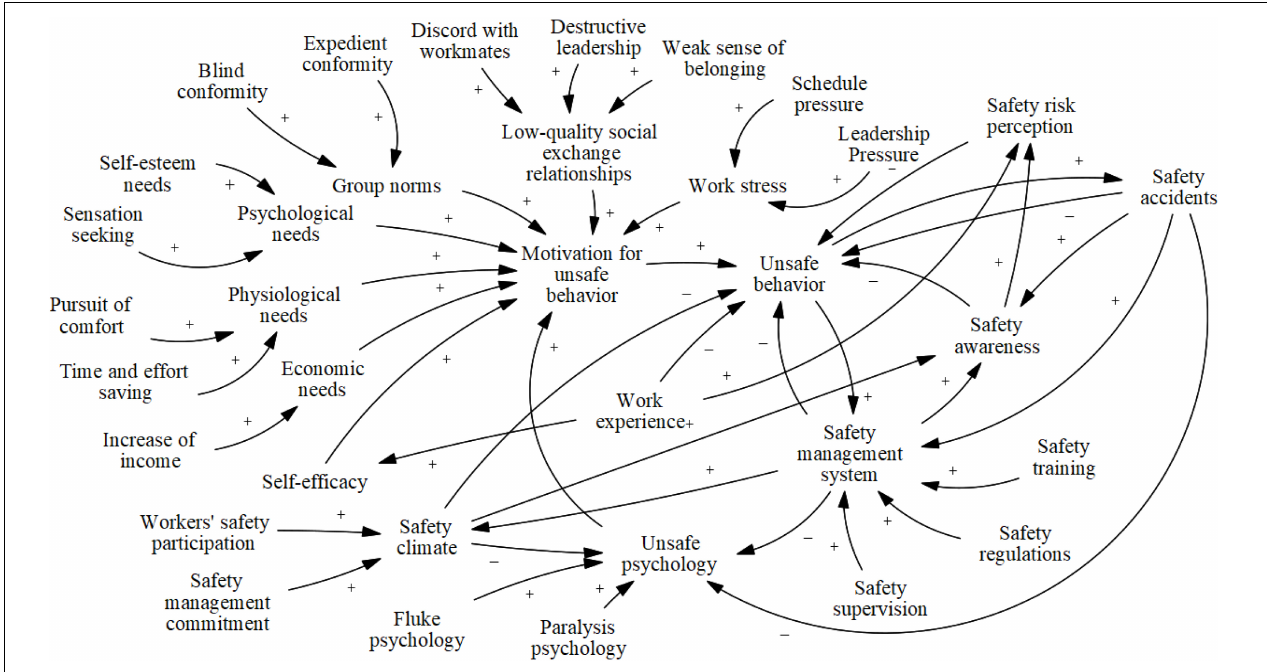
FIGURE 2 | The causal